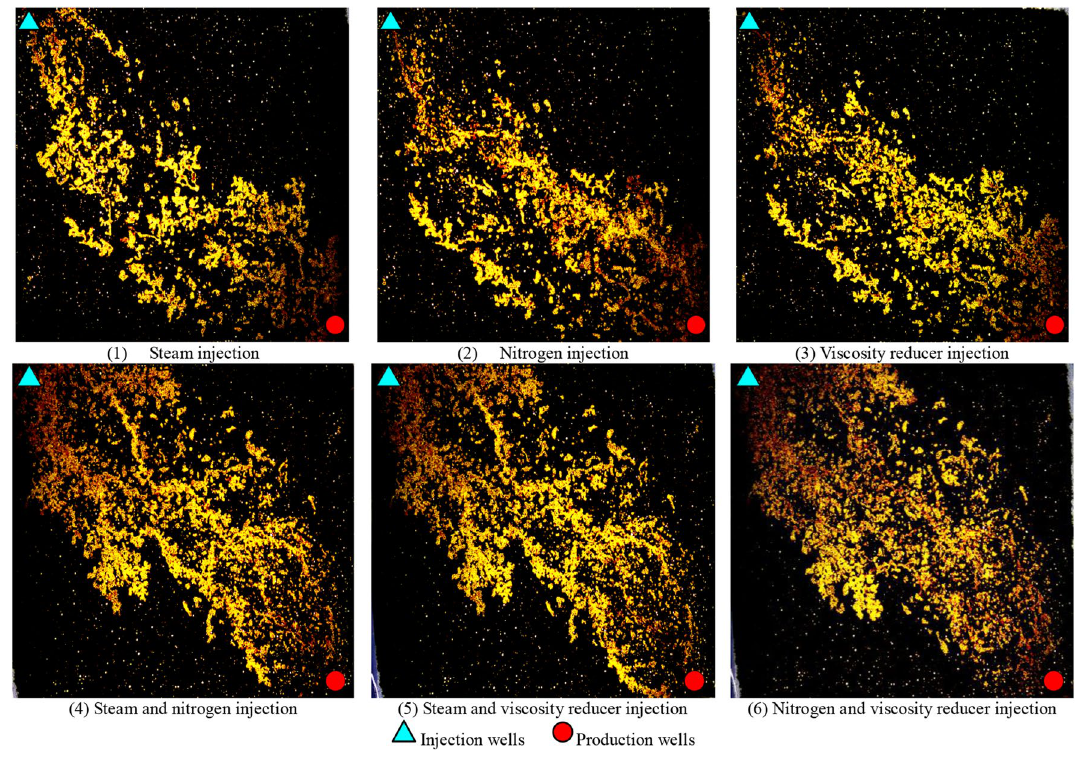
Fig. 4 The comparison diagram of areal swept zone of test 1